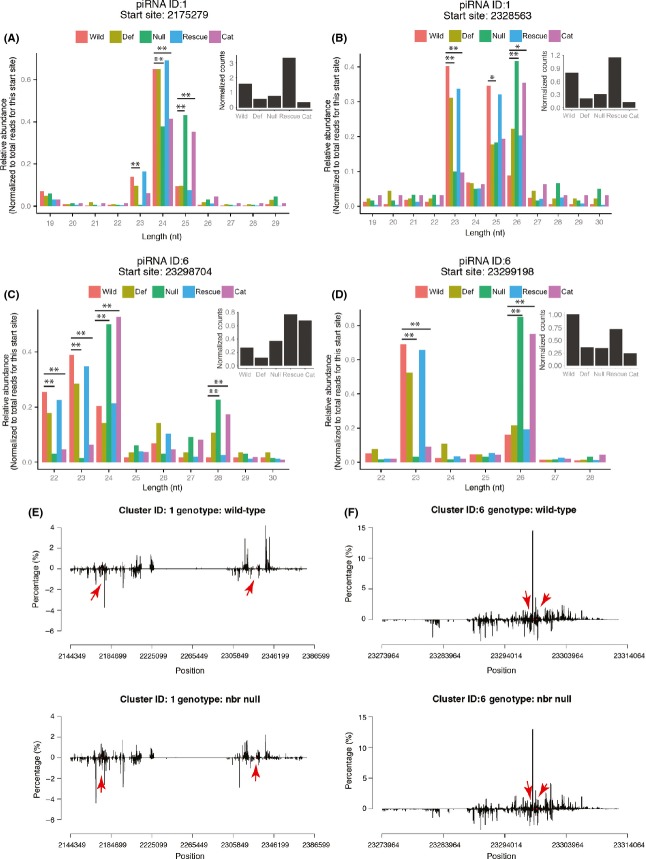
nbr affects the length of piRNAs with the same 5′end. A–D. Abundance of piRNA reads with the indicated length relative to the total number of reads originating from that specific piRNA locus and start site. Graphs for piRNA locus 1, start sites (A) 2175279 and (B) 2328563, and piRNA locus 6, start sites (C) 23298704 and (D) 23299198, are highlighted with red dots and arrows in E and F. Insert shows abundance of the specific reads plotted, which is not consistently different for the different genotypes. Start sites are numbered according to the position of the first nucleotide of the reads in the reference chromosome sequence (dm3 Drosophila genome assembly). E,F. Density plots of piRNA loci 1 (E) and 6 (F) for wild-type (top panels) and nbr null (bottom panels) flies. We observed no significant difference in genomic location of origin or overall read abundance of piRNA loci between the genotypes. The start positions for the piRNA reads that are of different length in nbr vs control in A–D are noted with red dots and highlighted with red arrows. Genotypes: wild, wild-type (w1118). def: nbr deficiency/+ (Df(3L)BSC312/+). null: nbr null (nbrf02257/Df(3L)BSC312). rescue: nbr null with genomic rescue of wild-type nbr (nbr null; pCaSpeR-nbr (wild-type)/+). cat: nbr null with genomic rescue with catalytically dead nbr (nbr null; pCaSpeR-nbr (D435A,E437A)/+). The t-statistic describing the ratio of departure in the abundance of piRNA reads compared to the wild-type control was calculated for each specific piRNA locus, start site, and read length. The t-statistic was then converted to the corresponding P-value using the sum total of reads being considered as the number of degrees of freedom, and it was adjusted for multiple comparisons using the false discovery rate (≤0.05). In addition, we computed Cohen's d to indicate the effect size. *P < 0.05 compared to wild-type and Cohen's d ≥ 0.6. **P < 0.01 compared to wild-type and Cohen's d ≥ 0.6. Detailed information on all piRNAs with significance is listed in Table S1 (Supporting information).